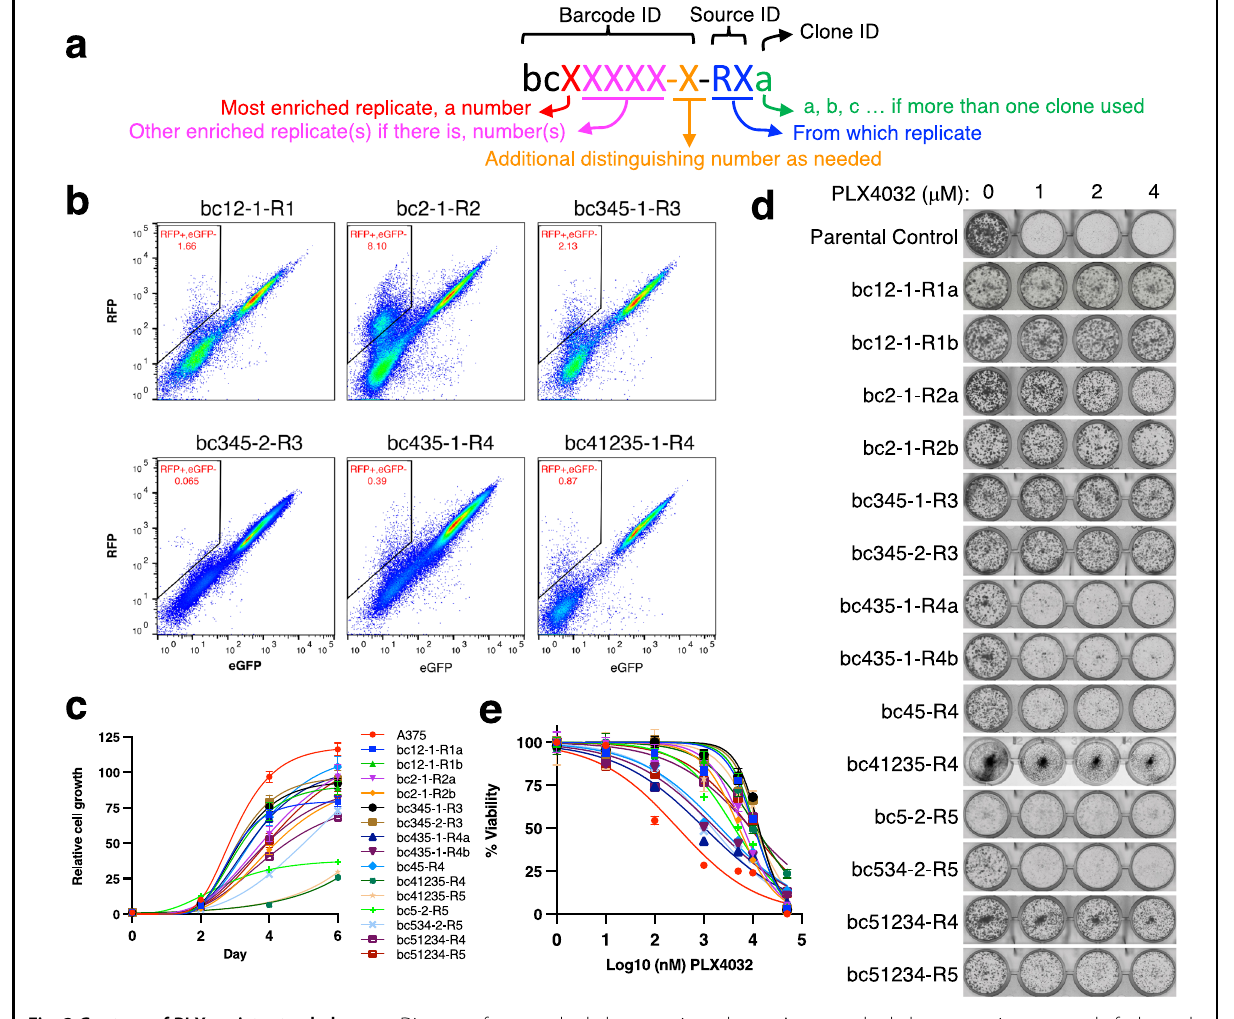
Fig. 3 Capture of PLX-resistant subclones. a Diagram of captured subclone naming scheme. A captured subclone name is composed of a barcode ID (referring to the carrying barcode), a source ID (capital letter “ R ” followed by a number to indicate from which replicate the cells were captured) and an optional clone ID (lower case letters). b Representative fl ow cytometry plot showing barcode isolation. c Cell growth curves of the captured subclones. Error bars represent the standard deviation of three technical replicates. d Colony formation assay showing the PLX resistance of captured barcoded subpopulations. Representative image of three independent replicates. e Cell viability of the captured clones in response to PLX. Error bars represent the standard error of the means of three technical